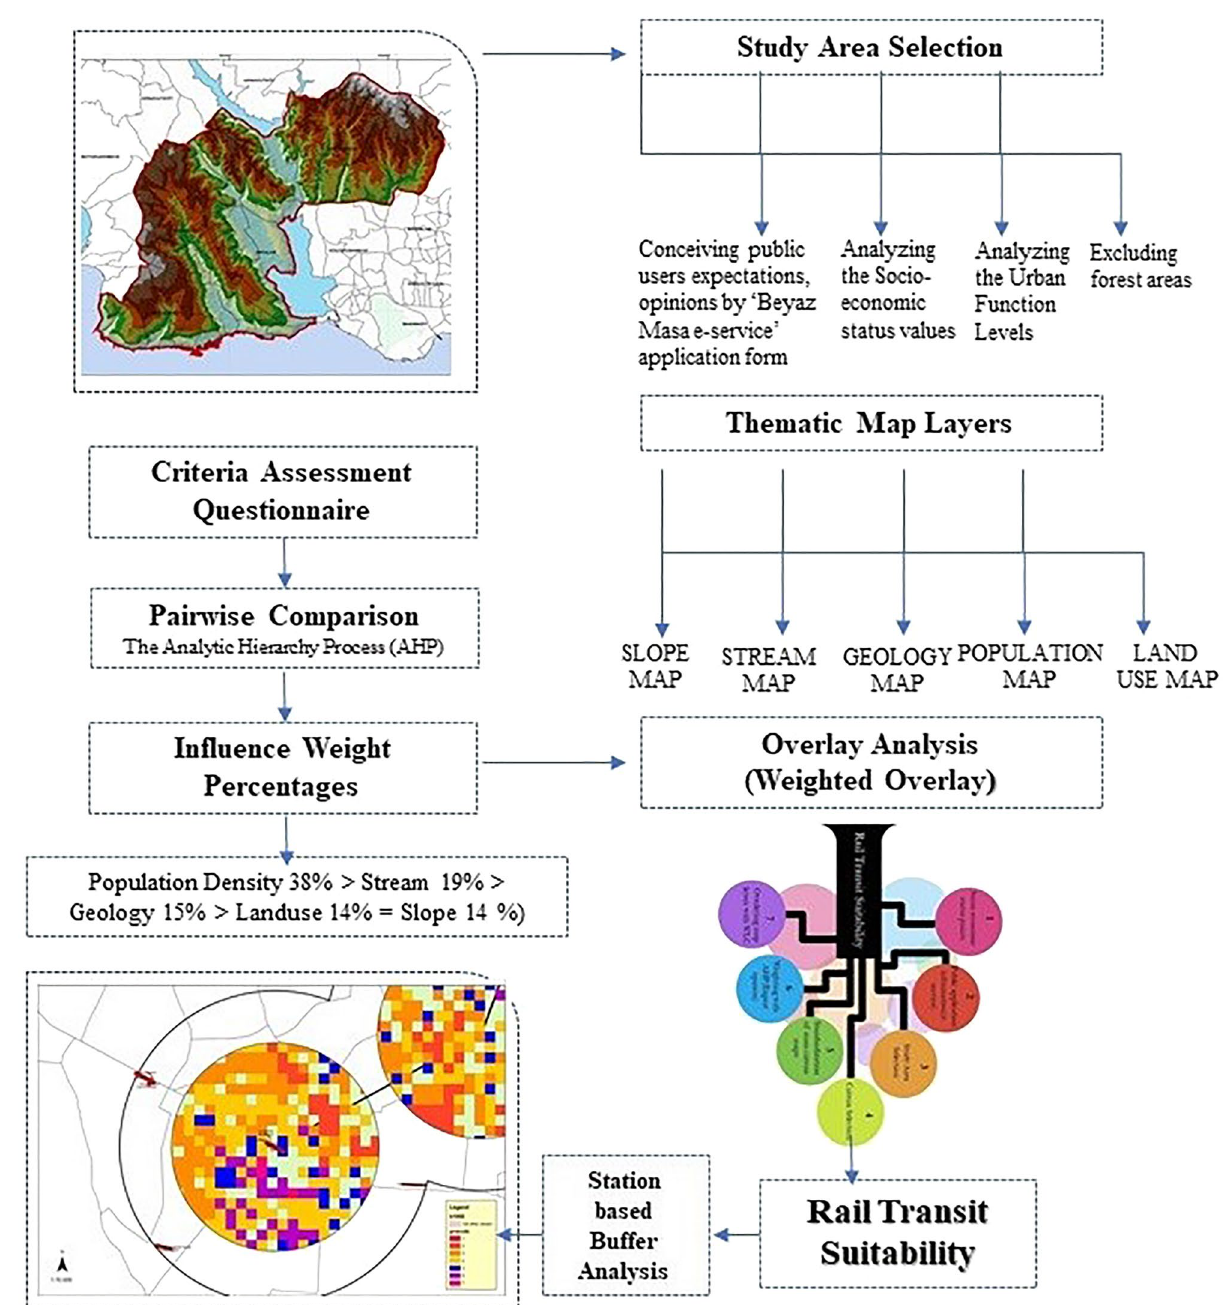
Fig. 3 Flow chart of